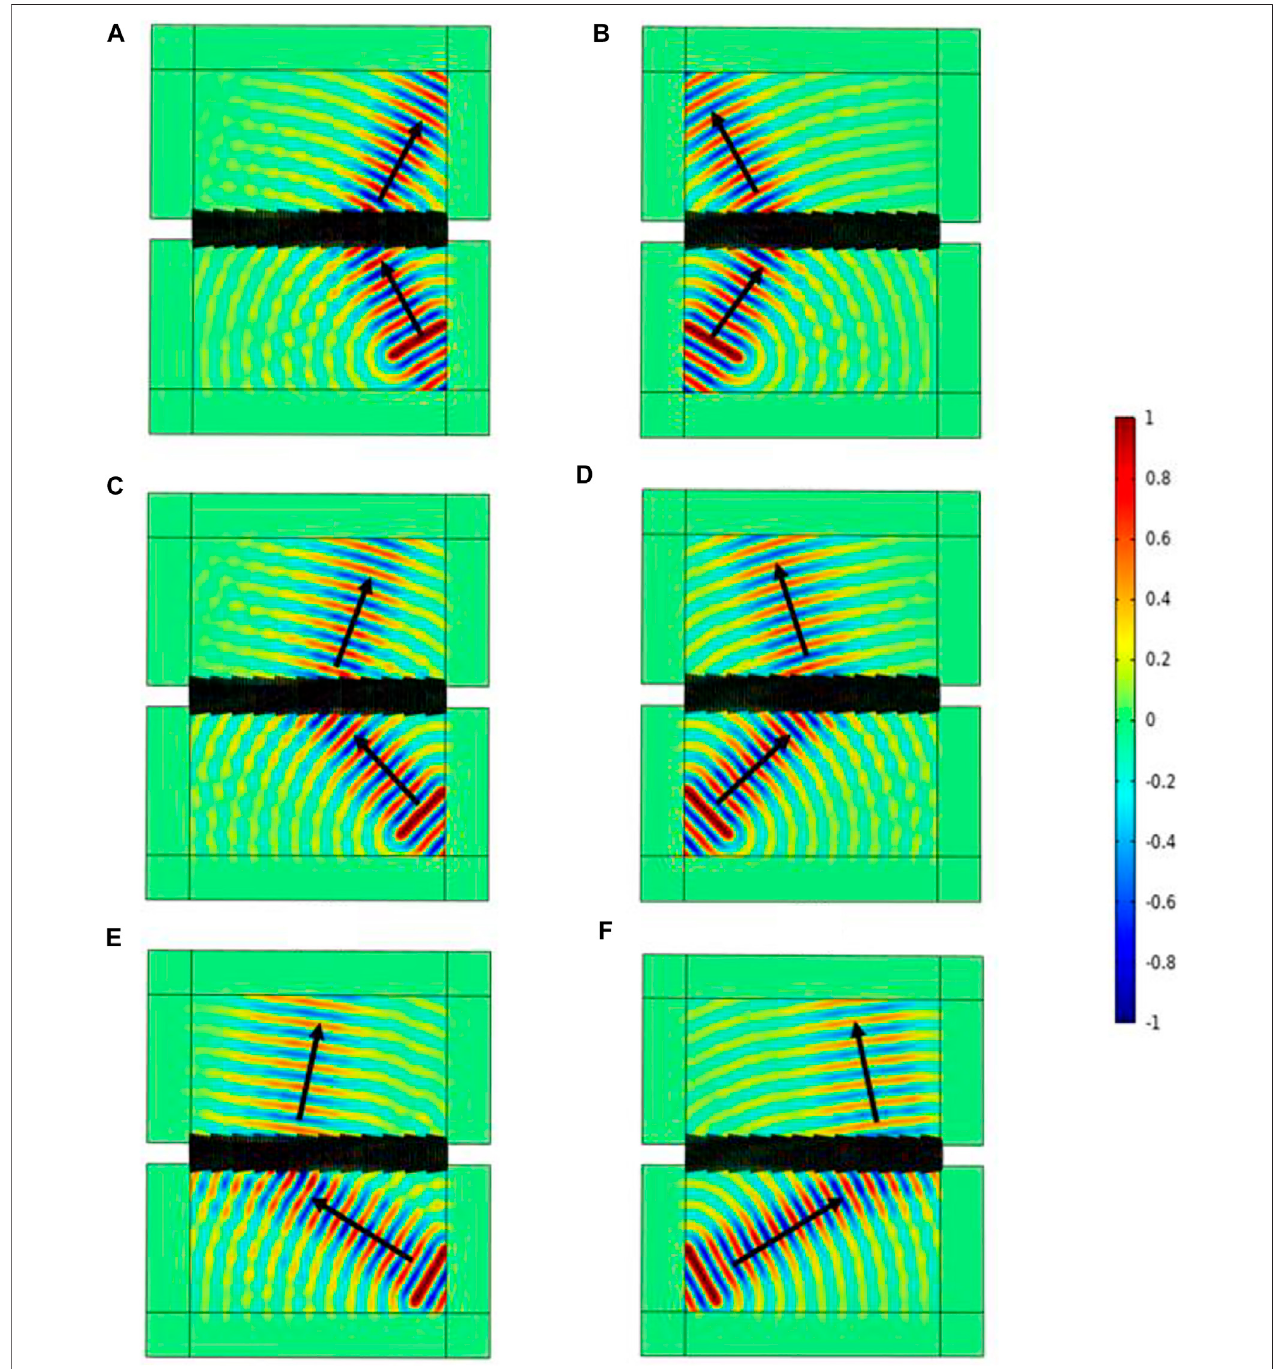
FIGURE 8 | Wide-angle negative refraction phenomenon of the incident waves: (A) 30 ° ; (B) -30 ° ; (C) 45 ° ; (D) -45 ° ; (E) 60 ° ; (F) -60 ° .